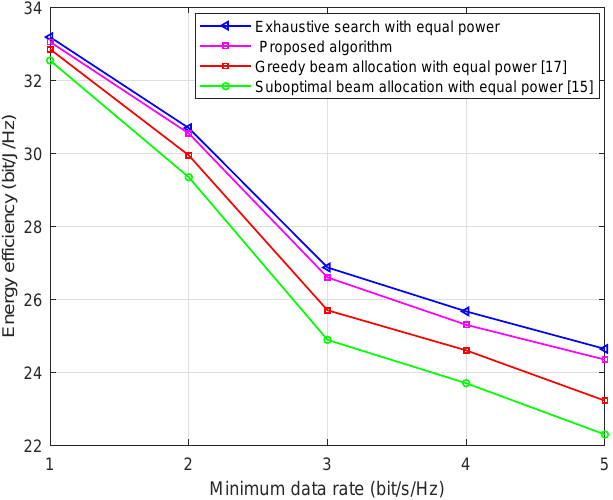
Figure 6. EE versus the required minimum data rate R min m , u with α = 2, P t = 30